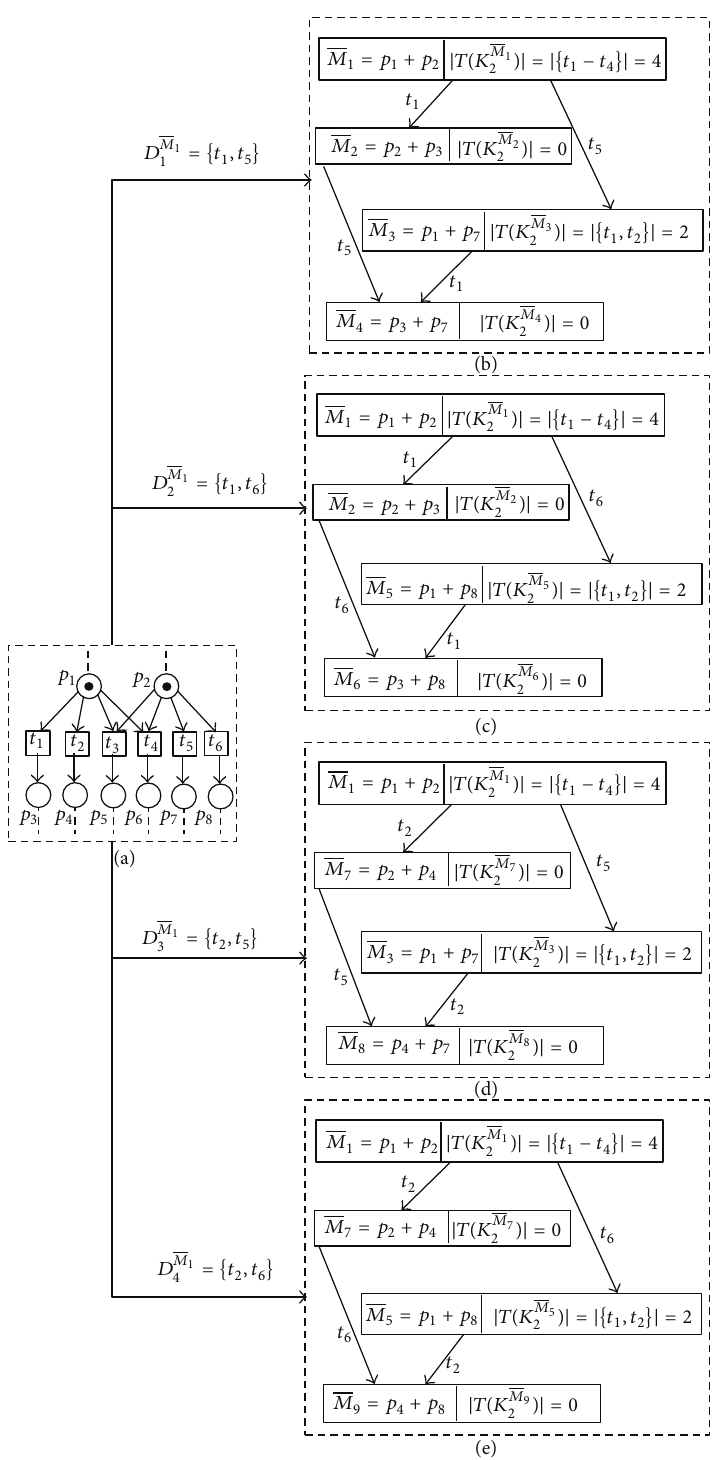
Figure5:ThepartialreachabilitygraphofaCDC( 𝑁 2 ,𝑀 1 )with |𝑇(𝐾 2 )| = 4 byconcurrentlyfiringtransitionsin 𝐷 𝑀 1 1 = {𝑡 1 ,𝑡 5 } , 𝐷 𝑀 1 2 = {𝑡 1 , 𝑡 6 } , = {𝑡 ,𝑡 } , and 𝐷 𝑀 1 = {𝑡 , 𝑡 } 𝐷 𝑀 1 2 5 2 6 3 4